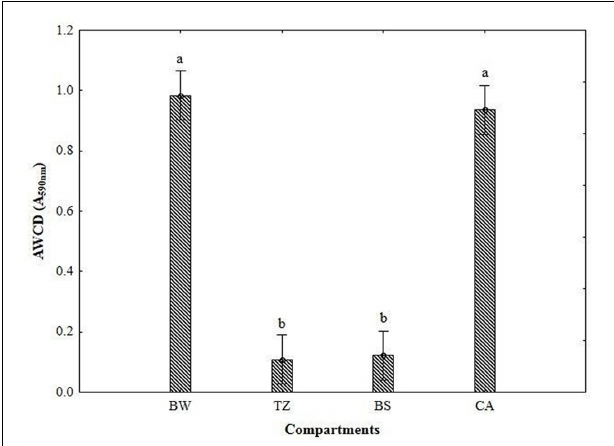
FIGURE 2 | Average well-color development (AWCD) of metabolized substrates calculated from Biolog data for different compartments of burrow system (BW, burrow wall; TZ, transitional zone; BS, bulk soil; CA, cast aggregates). Error bars represent 0.95 confidence intervals. The different letters indicate significant differences between the compartments at P < 0.05.